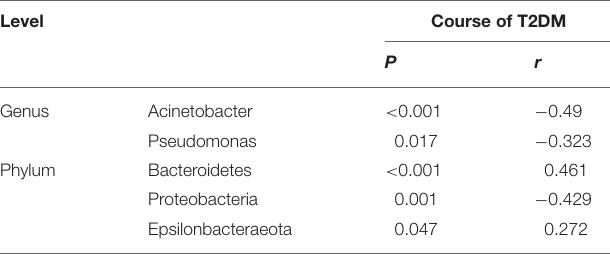
TABLE 3 | Relationship Between OS Microbiota and course of